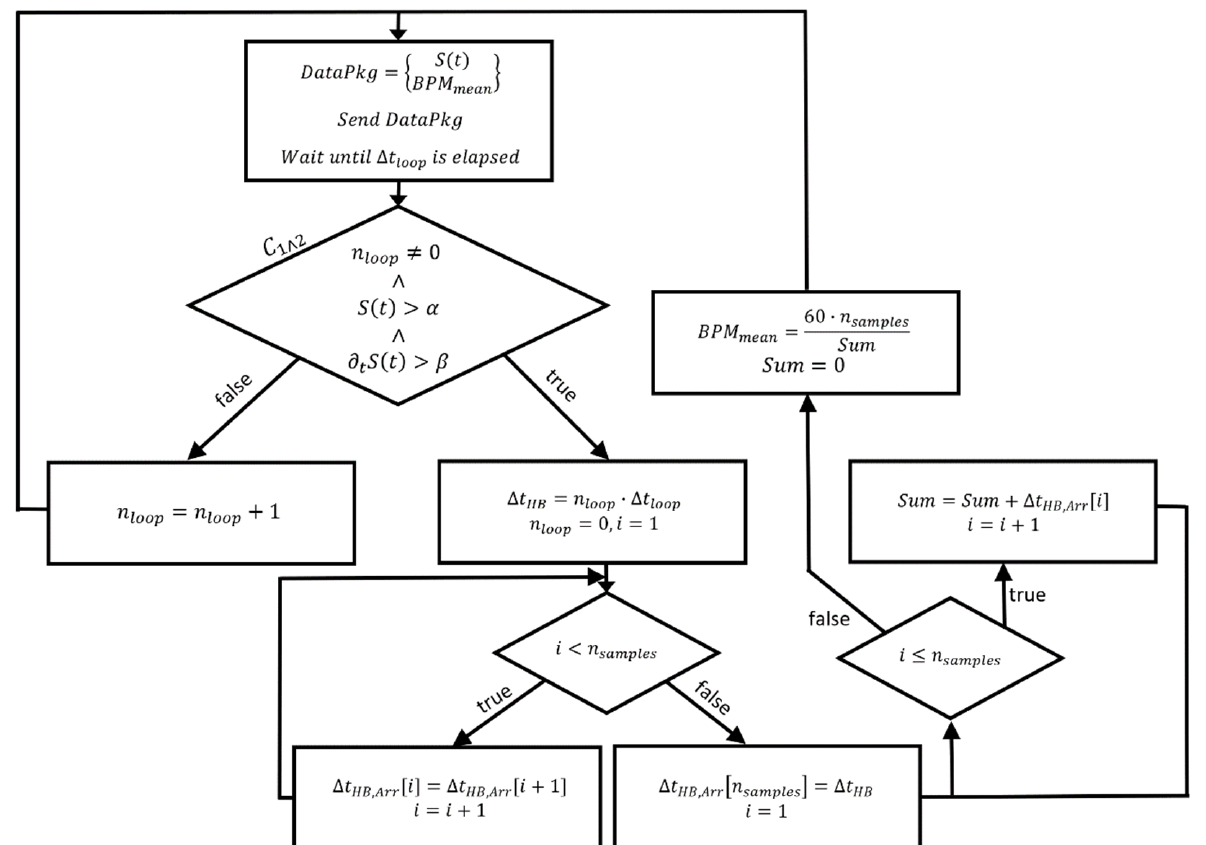
Figure 8. Flowchart of the average beats per minute (BPM) calculation.